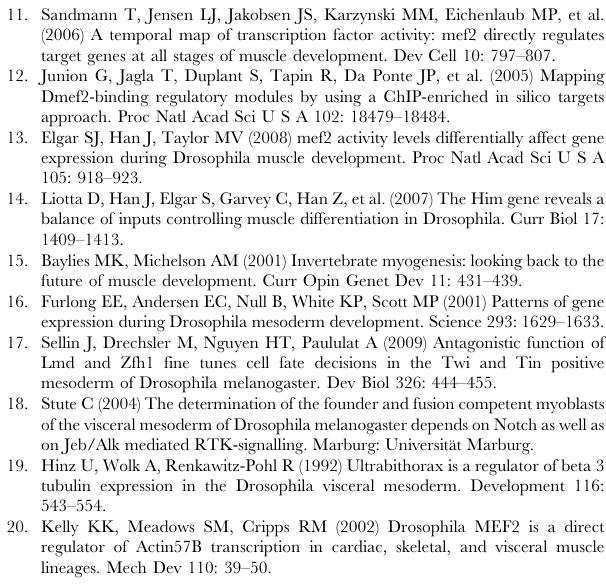
(white brackets). Note: The area indicated by the white brackets highlights the ectopic expression.